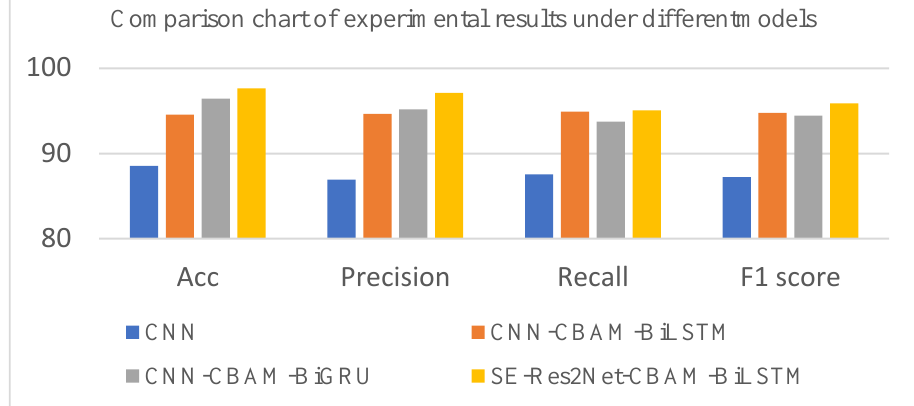
Figure 9. Comparison of experimental results under different models.